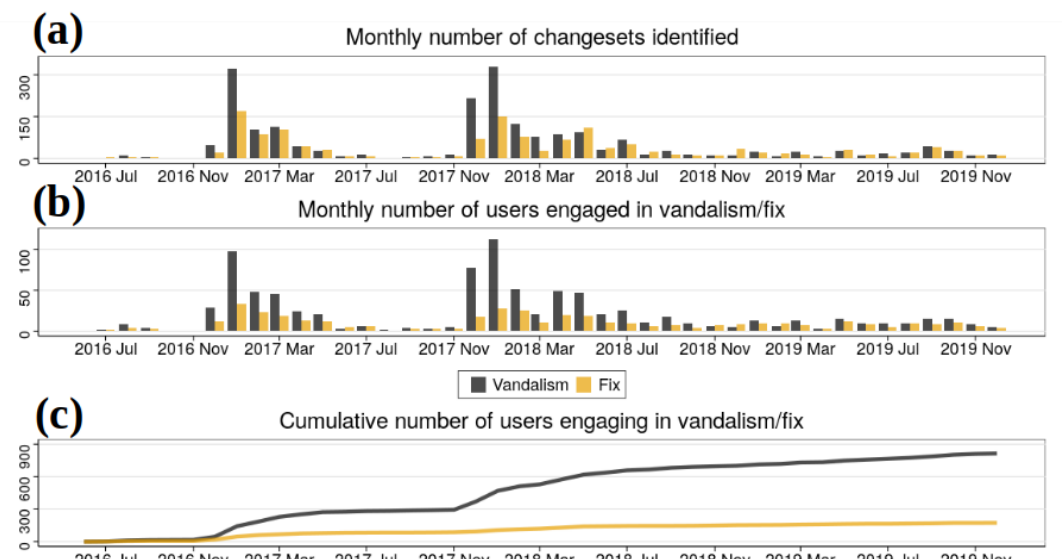
Figure 6. Timeline of PGO-related vandalism in OSM; ( a ) monthly number of changesets, ( b ) monthly number of users and ( c ) cumulative number of